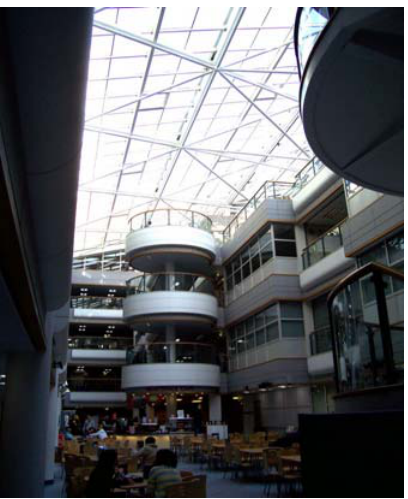
Figure 10. Northern Europe atrium—interior view.